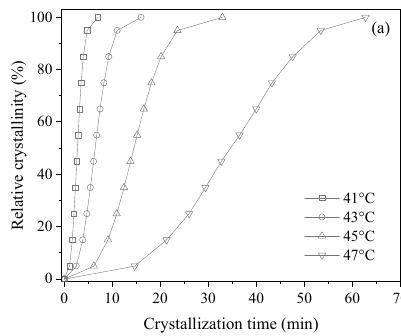
Figure 3. DSC cooling traces of PHS and PHS/CNC composites at 5 °C/min. The isothermal crystallization kinetics of PHS and PHS/CNC composites was also investigated in a crystallization temperature ( T c ) range of 41 to 47 °C after eliminating tion of heat flow with time was recorded and analyzed for both PHS and its composites.